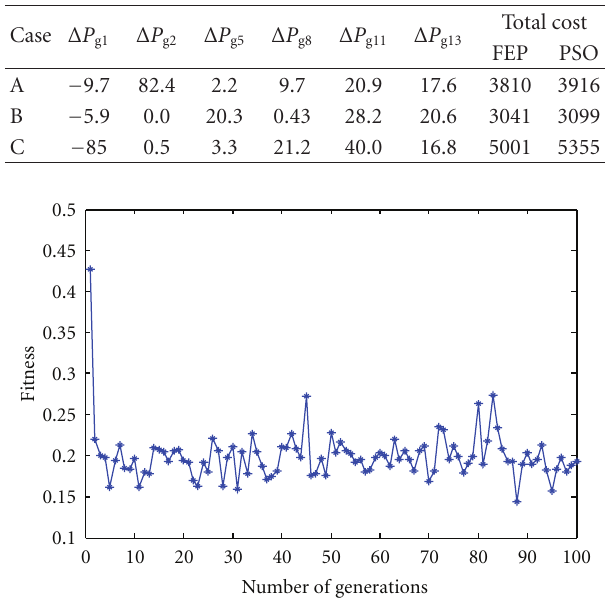
Table 3: Generation rescheduled power and congestion cost.